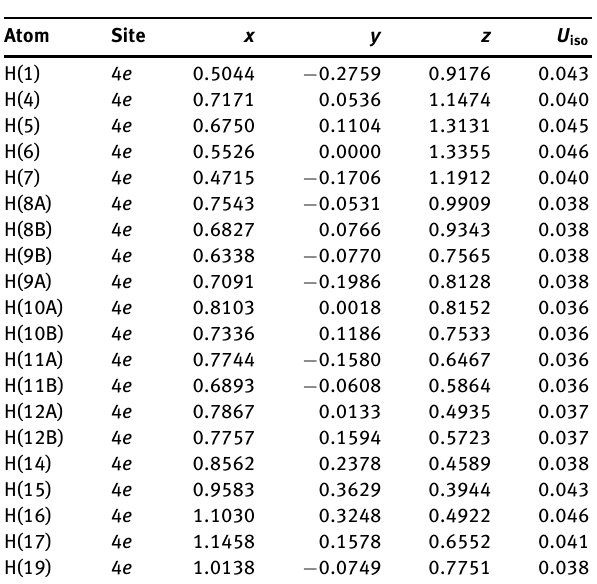
Table 2: Fractional atomic coordinates and isotropic or equivalent isotropic displacement parameters (Å 2